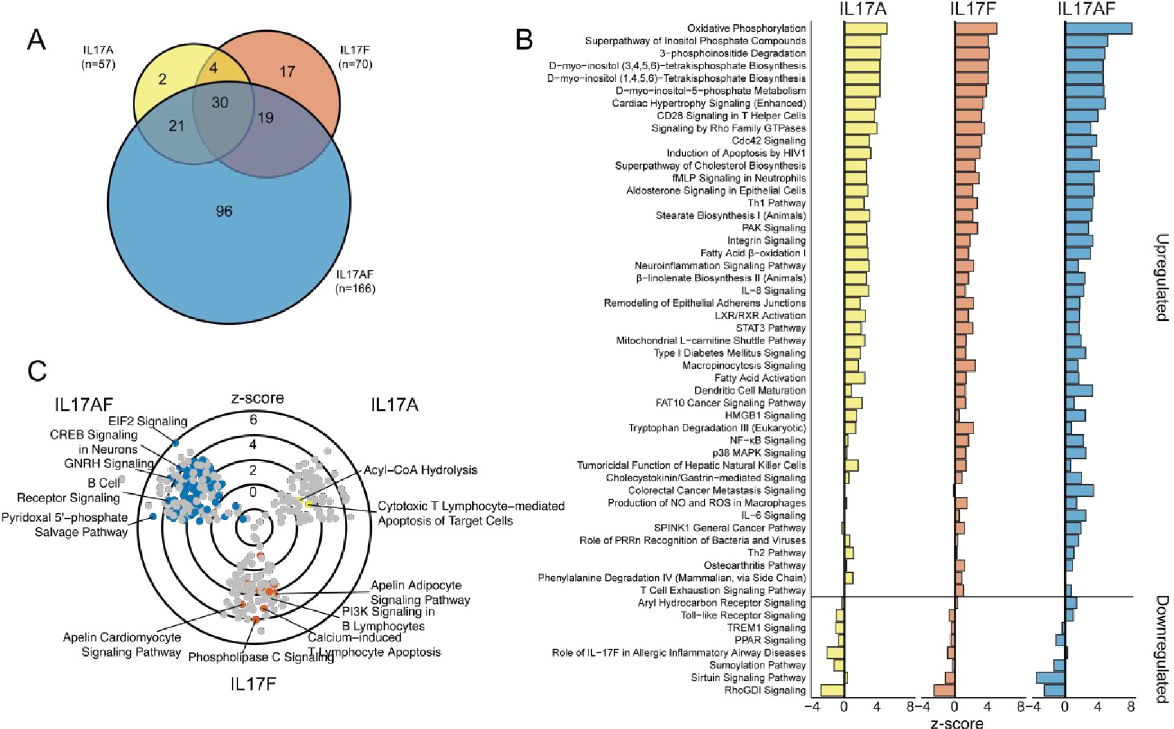
Fig 5. Pathway induction following IL-17 exposure. A . Overlapping and unique upregulated canonical pathway enrichment in bulk CD4 + CD25 - T-cells in IL-17A, IL-17F, and IL-17AF conditions compared to media-only cells. B . Bar chart of significantly (p < 0.05) altered in at least two of three conditions. C . Z-score of significantly enriched canonical pathways with non-unique pathways colored in grey. Top increased unique pathways labeled.